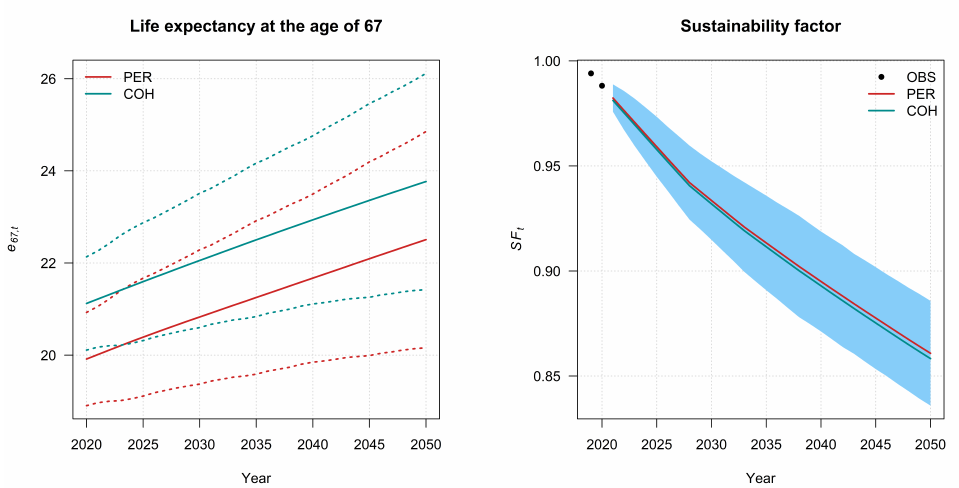
Figure 5. Spain: forecasts of the life expectancy and sustainability factor. Notes: the solid lines in the left panel represent the period (PER) or cohort (COH) life expectancy estimates at the age of 67, with the dashed lines representing the corresponding 95% MATA prediction intervals. In the right panel, the dots correspond to the actual values of the sustainability factor had it not been suspended. Table 4. Spain: sustainability factor, pension cuts, and extra working years